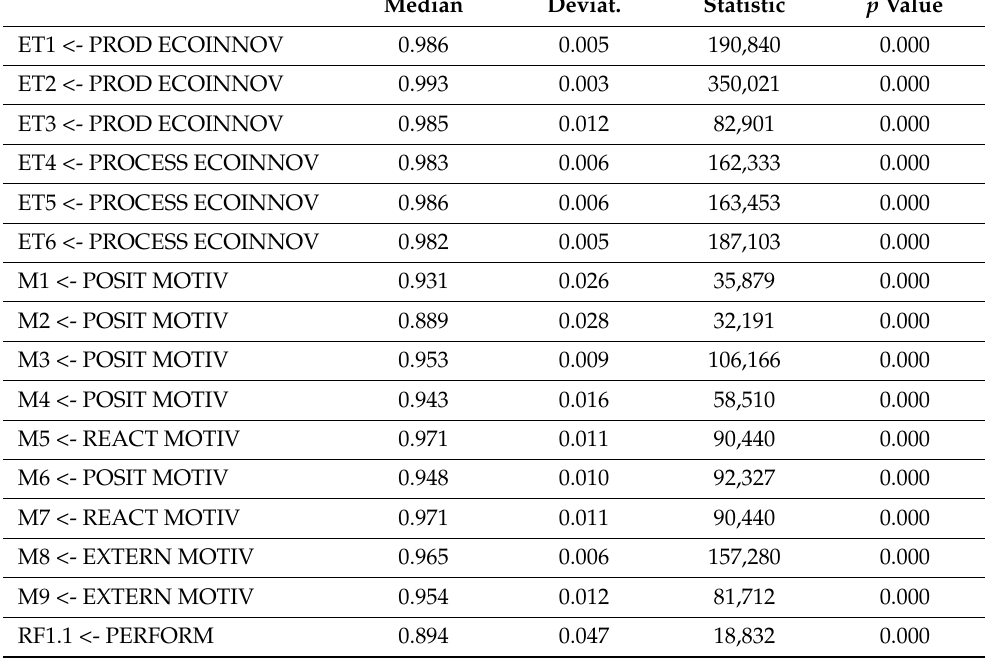
Table A4. Reliability analysis: loadings